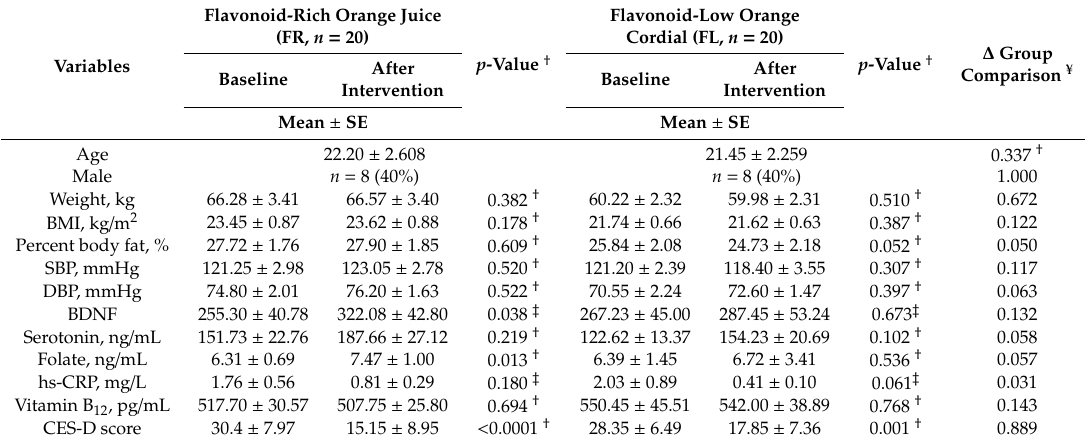
Table 1. Anthropometric data and blood test results at baseline and 8 weeks after intervention.